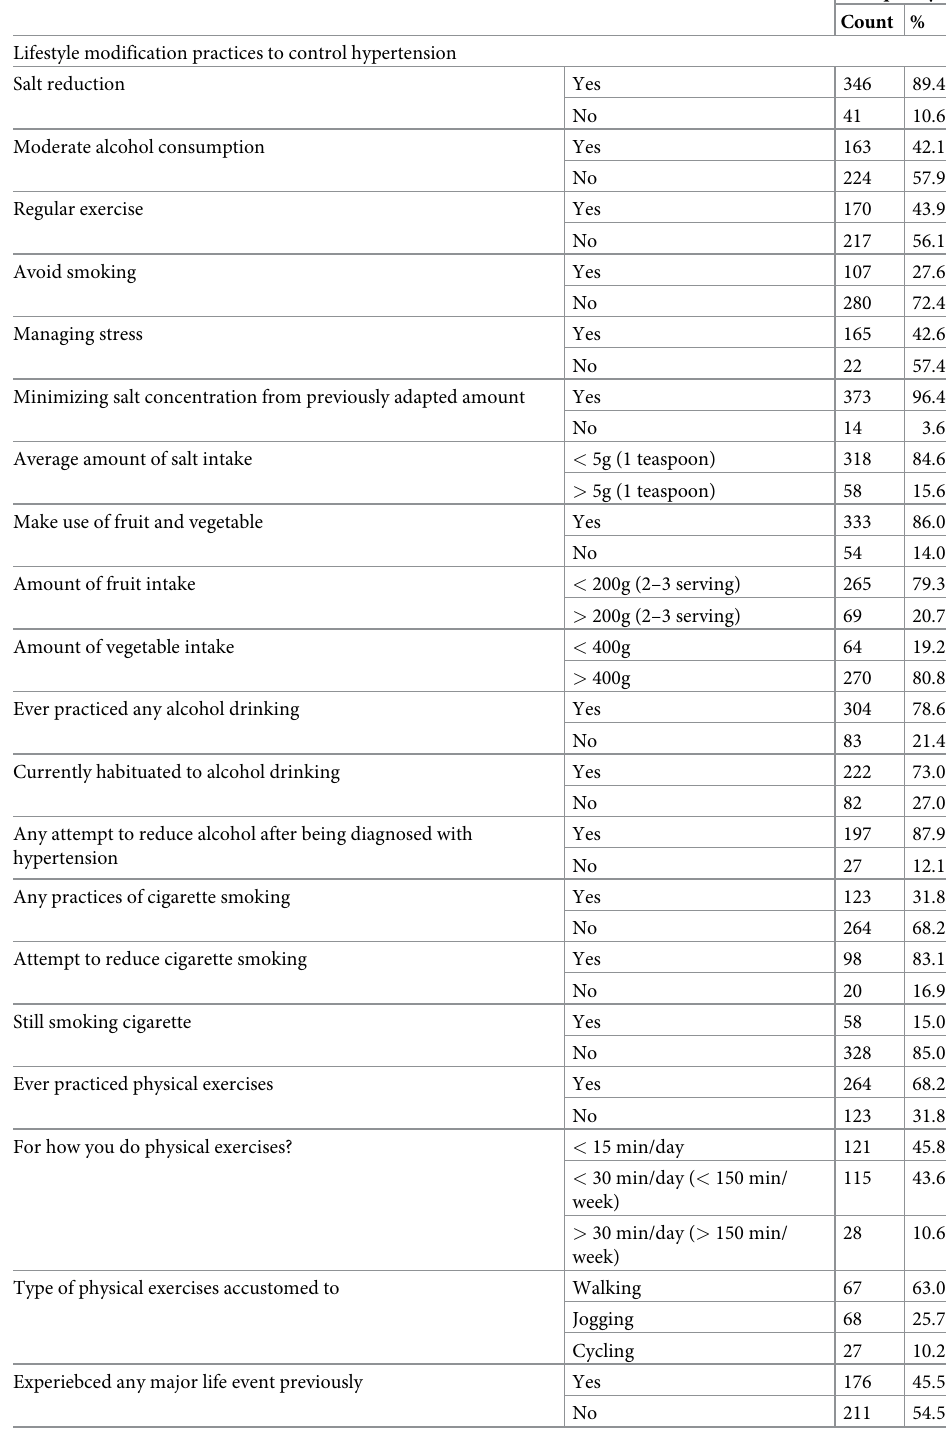
Table 6. Practices of hypertensive patients on treatment follow up regarding lifestyle modification at Yekatit 12 General hospital in 2019 (n =